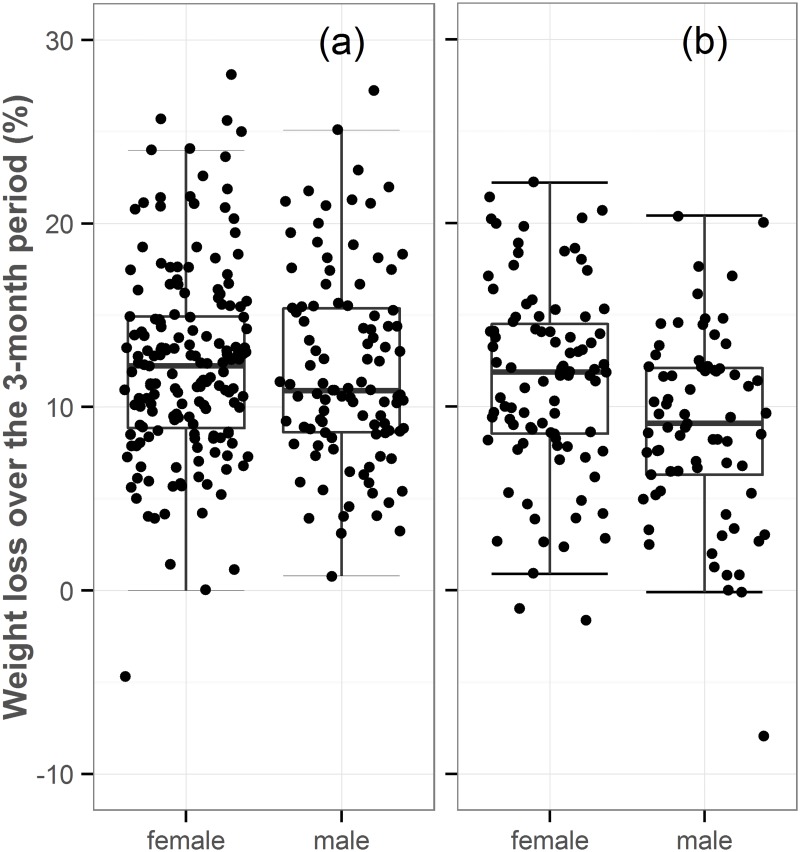
Box-and-whisker dot plots comparing percentage weight loss over the 3-month study in male and female dogs in Europe (a) and the Americas (b).The boxes depict median (horizontal line) and inter-quartile range (top and bottom of box), the vertical lines depict 1.5 times the inter-quartile range, and individual dogs are shown by the black circles.